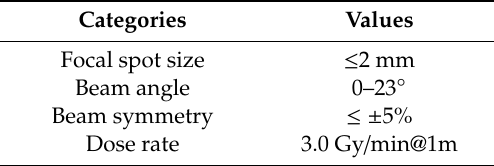
Figure 2. Photographic image of a 1 − 3 MeV energy X-ray system consisting of an X-ray tube (focal spot size 2 mm) with a linear accelerator (LINAC) and large-area flat-panel detector (pixel size = 200 µ m, 2048 × 2048). Table 1. Specifications of the X-ray generator at 3